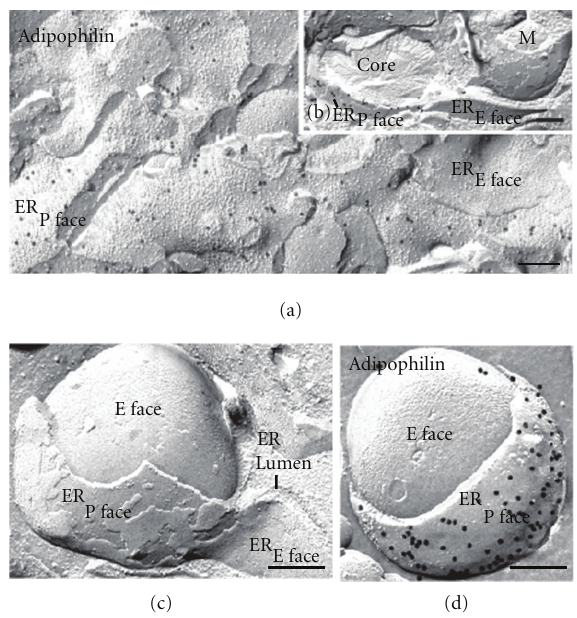
Figure 8: Freeze-fracture views of lipid droplet and ER membrane associations in lipid-laden macrophages immunogold-labeled for adipophilin. (a) ER membranes are visible in both P face and E face views. Moderate labeling is seen in the P faces of the ER membranes. (b) Lipid droplet closely associated with ER membranes. Abundant gold label marks the presence of adipophilin in the ER membrane immediately adjacent to the lipid droplet. In contrast, ER membranes adjacent to mitochondria (M) are devoid of label. (c) Lipid droplet situated in a cup formed from ER membranes. The lipid droplet has been convexly fractured and lies beneath (i.e., adjacent to and not within) both ER membranes exposed. (d) Similar view to (c) but with labeling for adipophilin using the FRIL technique. Abundant gold label marks the presence of adipophilin in the ER membrane (P face) immediately adjacent to the lipid droplet. Bars: 0.2 μ